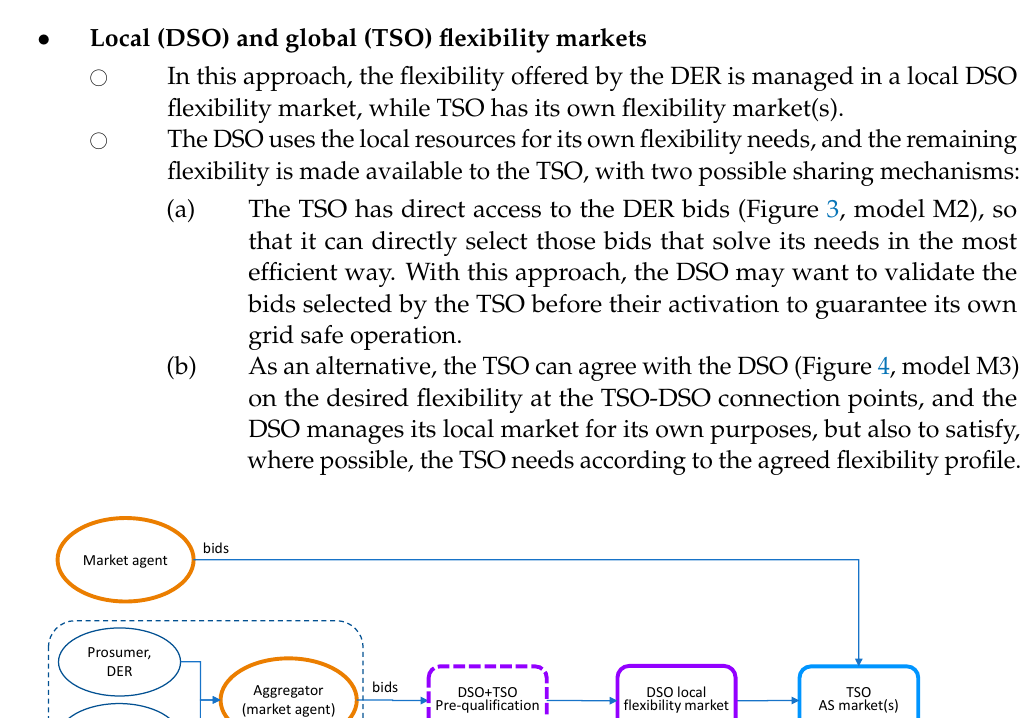
Figure 2. Centralized TSO flexibility market (M1).